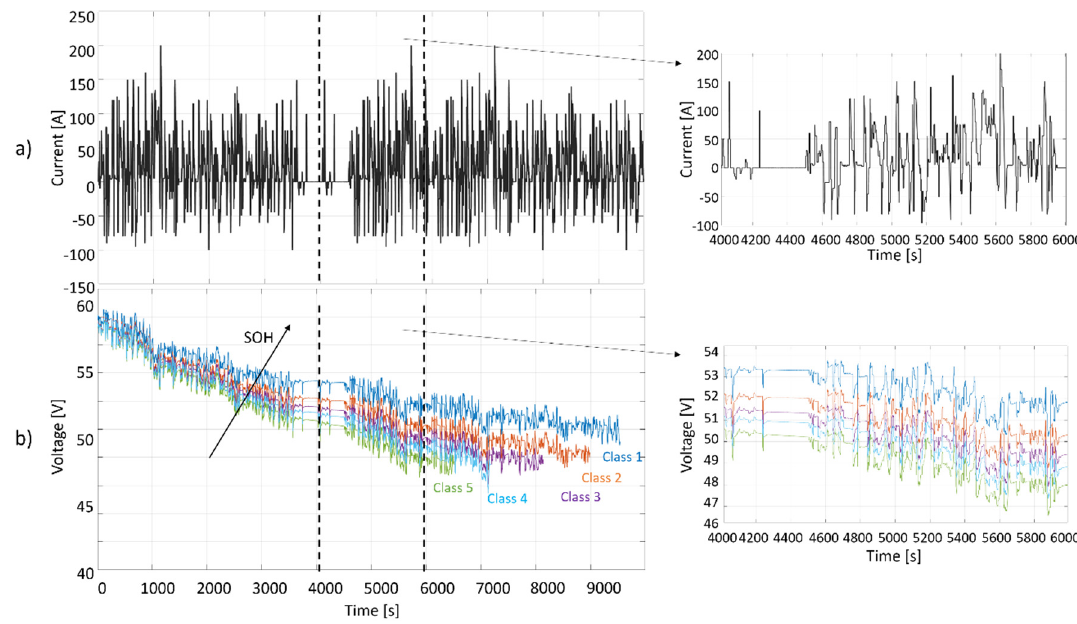
Figure 8. ANN validation datasets recorded from a real mild hybrid vehicle. ( a ) Current i ( t ) . ( b ) Voltage v ( t ) at four di ff erent degradation levels corresponding to the four SOH classes.